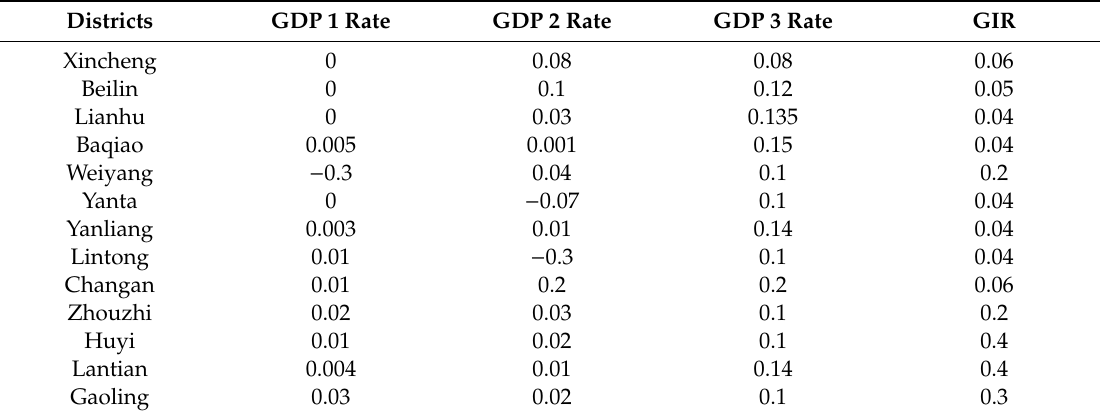
Table A3. Parameter setting of environmental protection scenario.